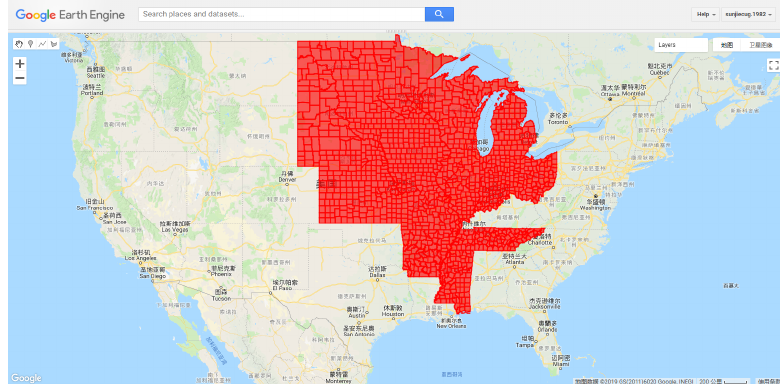
Figure 1. Study area in the Google Earth Engine (GEE) (red areas show selected